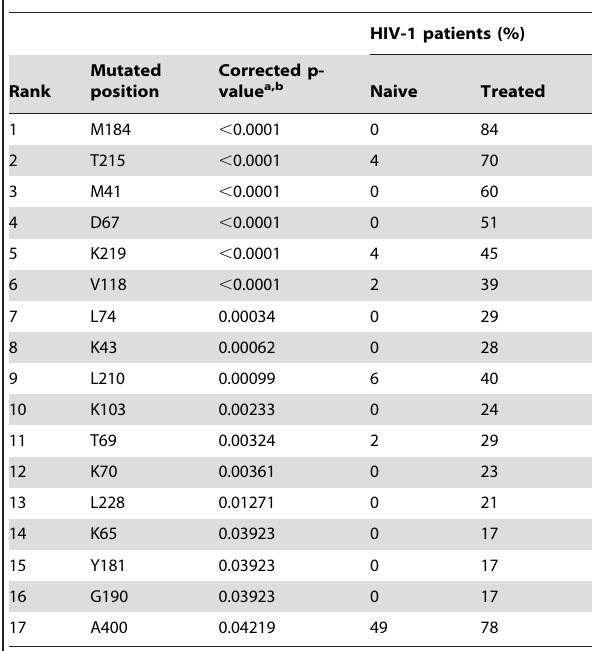
Table 1. Changes in the RT sequence of HIV-1 subtype B viruses that are found with increased frequency in patients failing therapy.